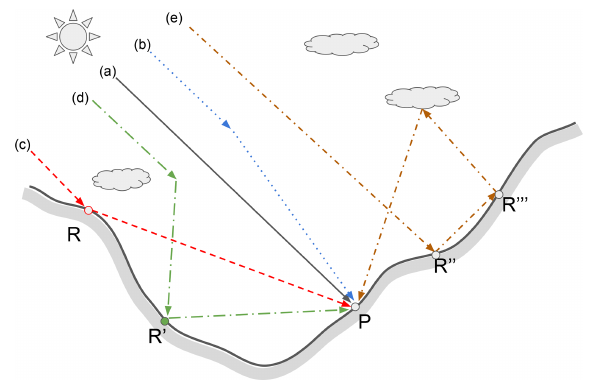
Figure 1. Conceptual representation of the five flux components used to characterize the nature of downward shortwave fluxes over rugged terrain, following the formalism used by Chen et al. (2006) and Lee et al. (2011). The figure includes the direct radiation flux (a) and diffuse radiation (b) , consisting of photons which are ab- sorbed at the surface target P after undergoing atmospheric scat- tering. Direct-reflected (c) and diffuse-reflected (d) fluxes represent photons that are reflected once at the surface. Finally, the coupled (e) flux component includes light undergoing multiple reflections at the surface or reflection at the surface and then atmospheric scatter- ing. For all components, the figure shows paths incident at a point P at the